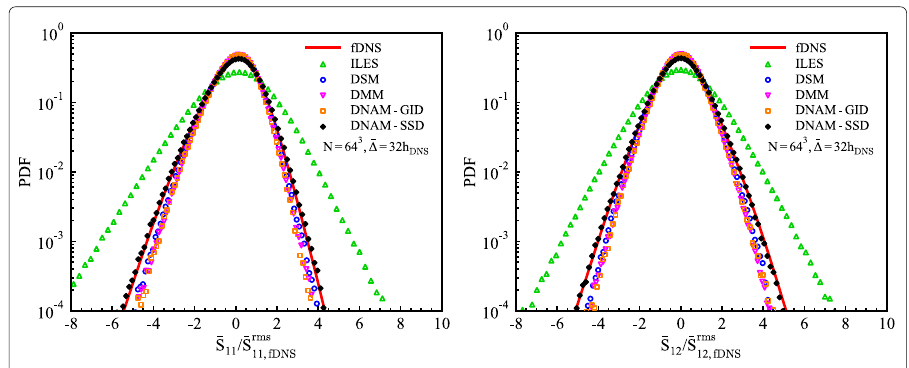
Fig. 9 PDFs of the normalized strain-rate tensor in aposteriori study at filter scale 32 h